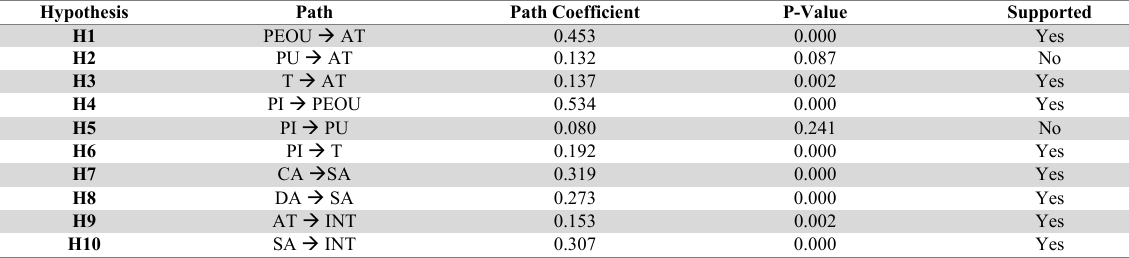
Results of the structural model and hypotheses tests